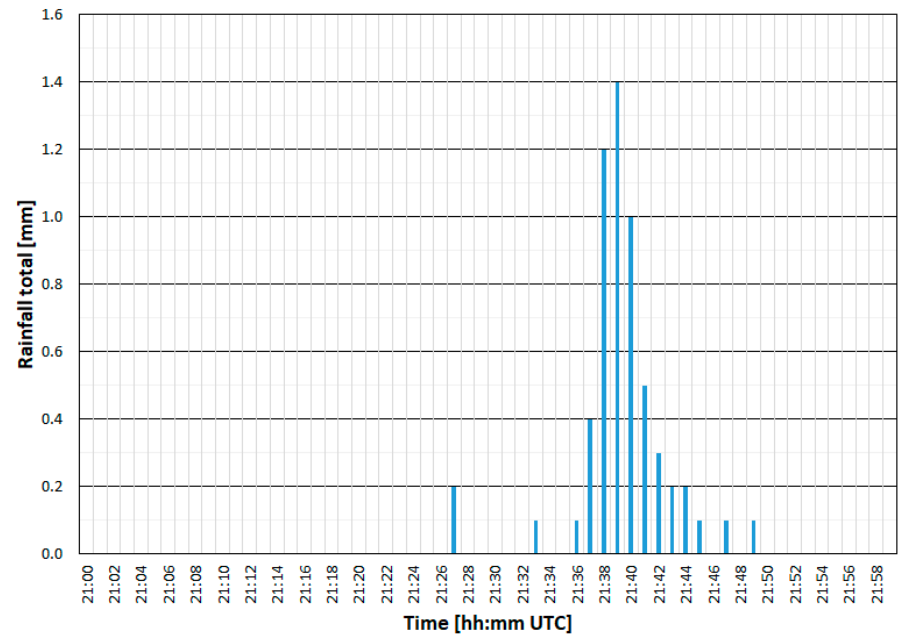
Figure 3. Rainfall totals with a 1-min time step recorded by a rain gauge at the Milešovka observatory from 21 to 22 h UTC on 10 June, 2019.